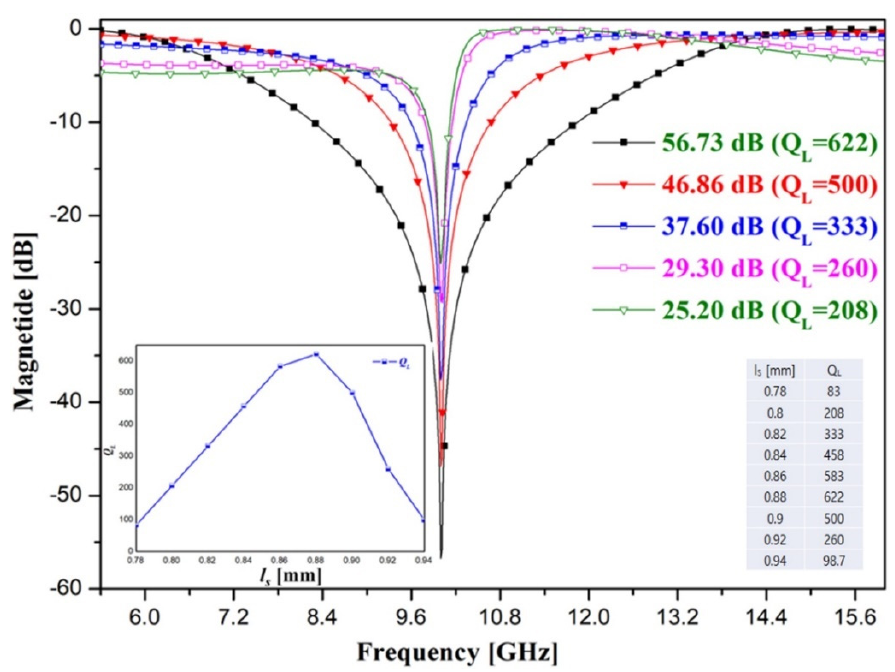
Figure 4. Q L change process in the resonator design stage.